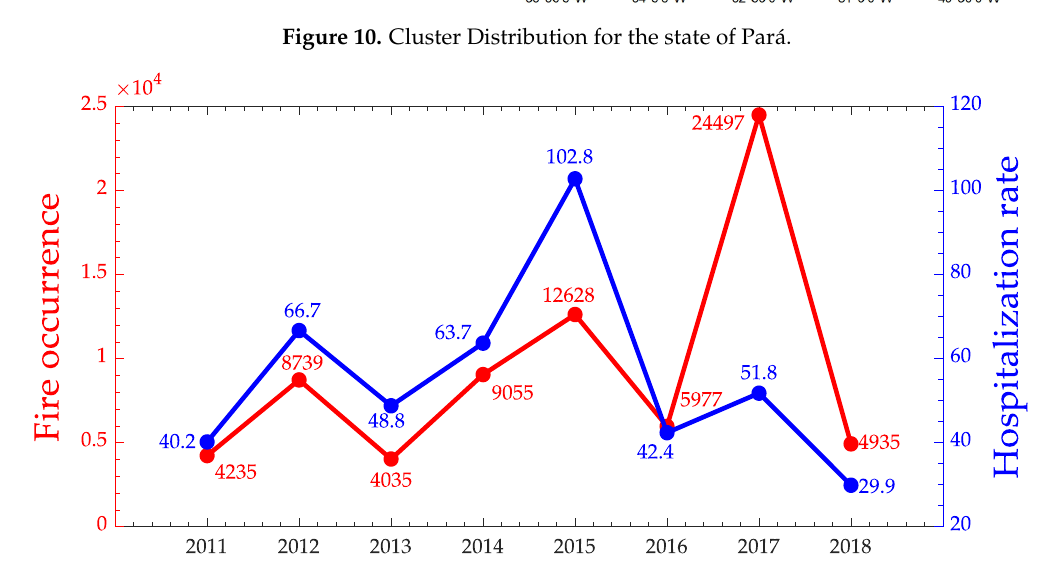
Figure 11. Time series of fire occurrences in red and Malaria/Leishmaniasis hospitalization rate in blue for Pará